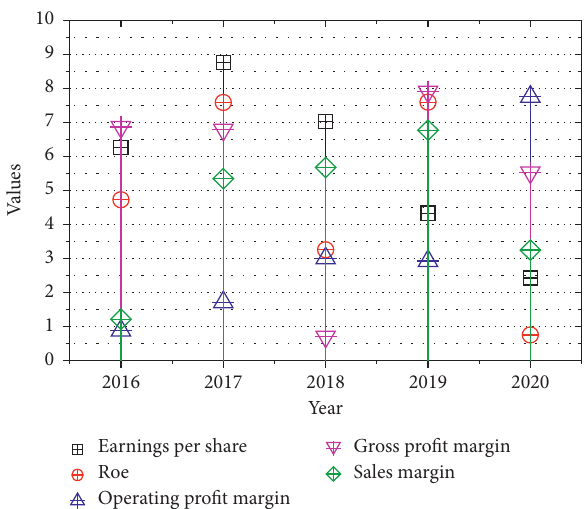
Figure 7: Annual changes in the company’s profitability indicators for 2016–2020.